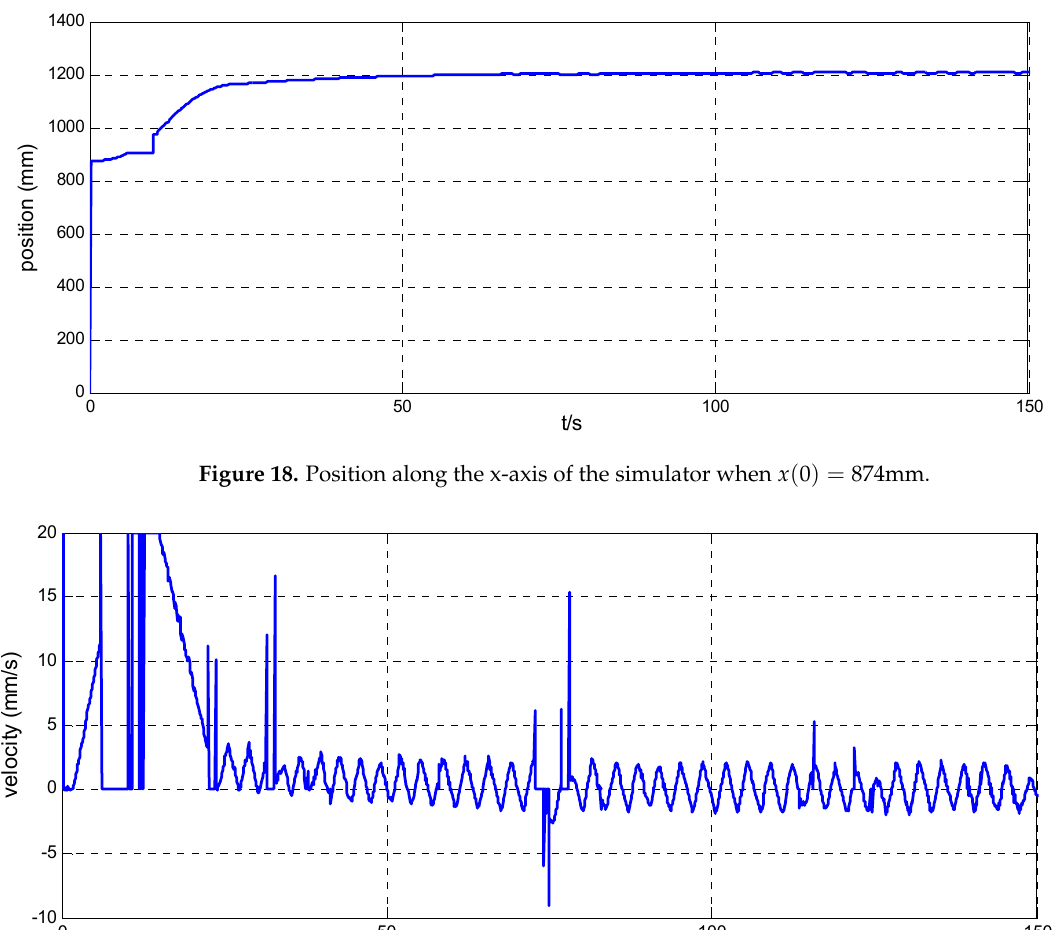
Figure 17. Relative position error inside the simulator when x ( 0 ) = 1036mm. Figures 18–21.